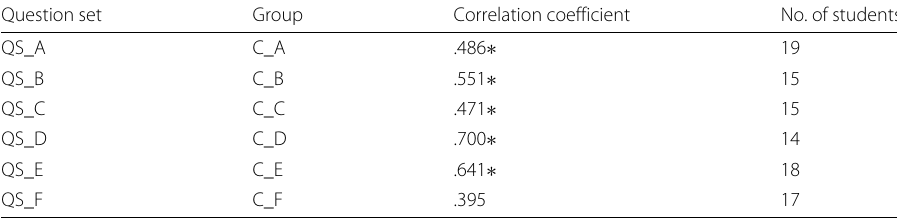
Table 4 Correlation of test taker’s scores (extreme cases removed) Question set Group Correlation